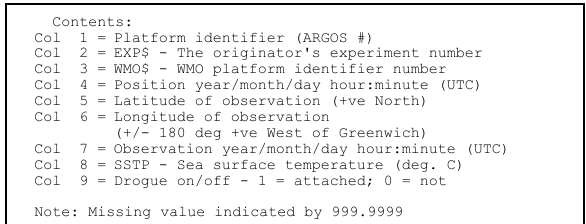
Table 2. Header of ARGO drifting buoy data